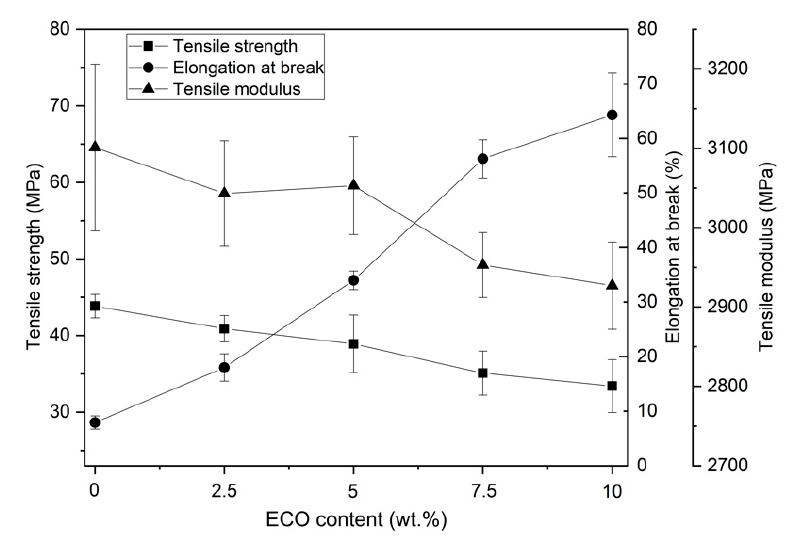
Figure 3. Plot evolution of tensile mechanical properties of PLA with different epoxidized chia seed oil (ECO) contents.